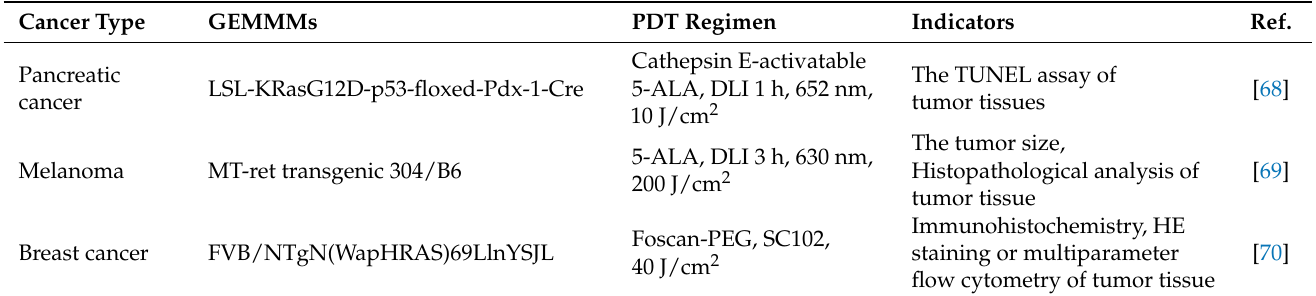
Table 4. Application of GEMMs in antitumor study of